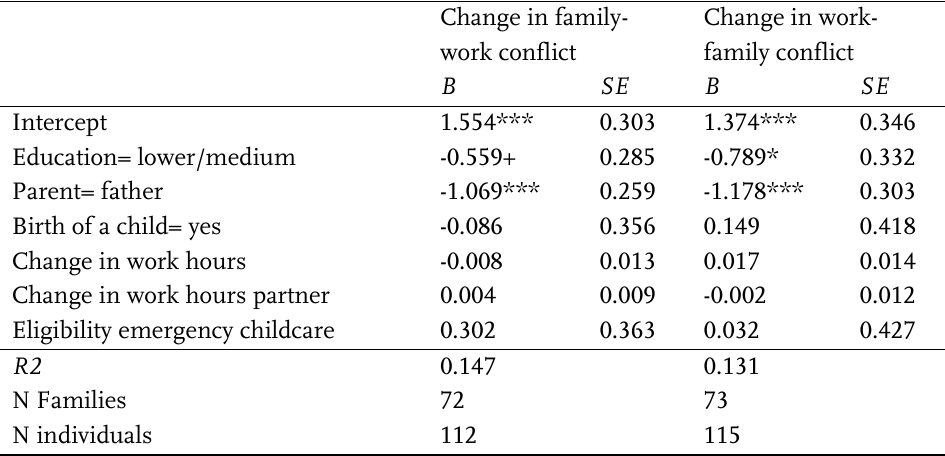
Table A.2a: Multilevel regression model on change in F → W-conflict and W → F-conflict, controlling for the eligibility of using emergency